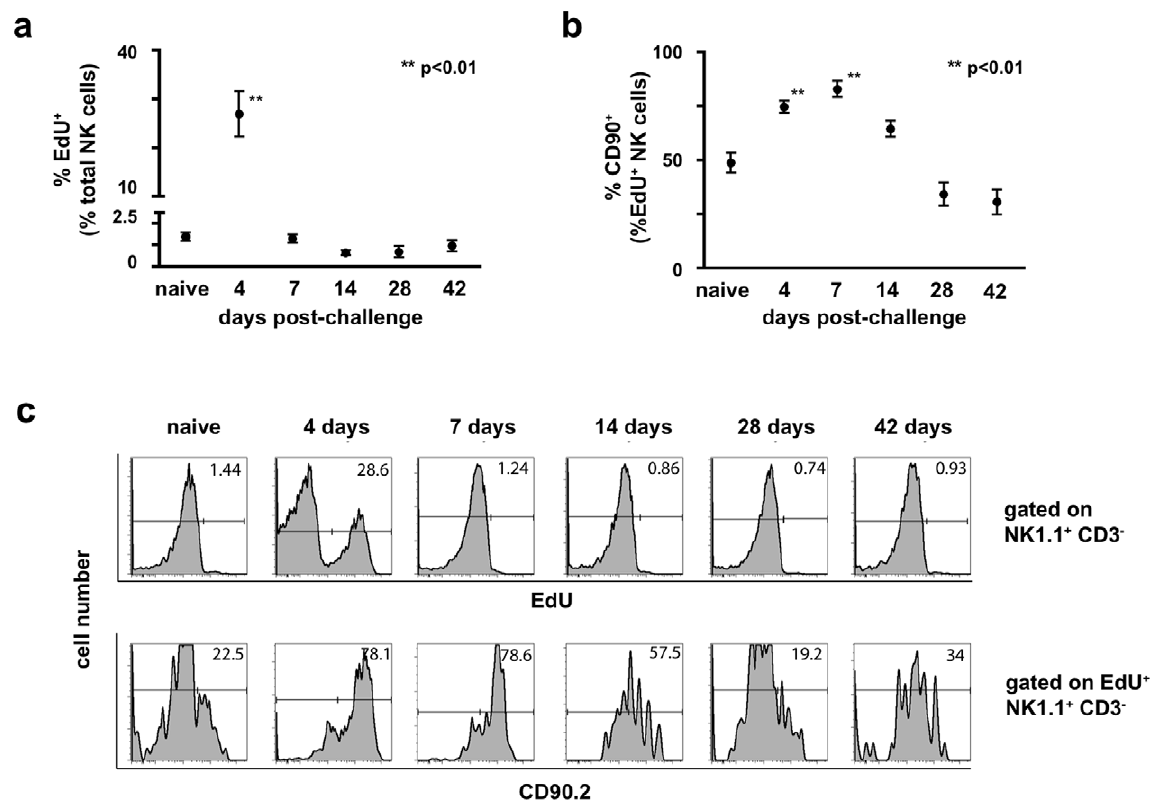
Figure 5. Expansion of the NK cell population post-challenge is driven by proliferation insitu . Groups of B6 mice were either infected with 1 6 10 7 pfu rVV ip or given a control injection of PBS. The thymidine analog 5-ethynyl-2 9 -deoxyuridine (EdU) was administered ip 12 hours prior to sacrifice (250 m g EdU/animal). Cell suspensions isolated from liver were stained with monoclonal antibodies to CD3, NK1.1, and Thy1 (CD90.2), fixed, permeabilized, and treated with the Click-IT EdU staining buffer with Alexa 647 azide to detect EdU incorporation. (a) The percentage of liver NK cells (CD3 2 NK1.1 + ) that incorporated EdU is plotted over time. Statistical analyses were performed using t tests and Mann-Whitney analysis comparing the various time points to that of the naı¨ve control group. Statistically significant differences between virally-infected groups post- challenge and the uninfected control group are indicated by one (p , 0.05) or two (p , 0.01) asterisks. (b) The percentage of EdU + liver NK cells expressing Thy1 (CD90.2) is plotted over time. Statistical analyses were performed using t tests and Mann-Whitney analysis comparing the various time points to that of the naı¨ve control group. Statistically significant differences between virally-infected groups post-challenge and the uninfected control group are indicated by one (p , 0.05) or two (p , 0.01) asterisks. (c) Representative histograms measuring EdU incorporation by total liver NK cells is shown in the top panel, while representative histograms measuring Thy1 (CD90.2) expression by cells within the corresponding EdU + gate are represented in the lower panel. These results are representative of two independent experimental